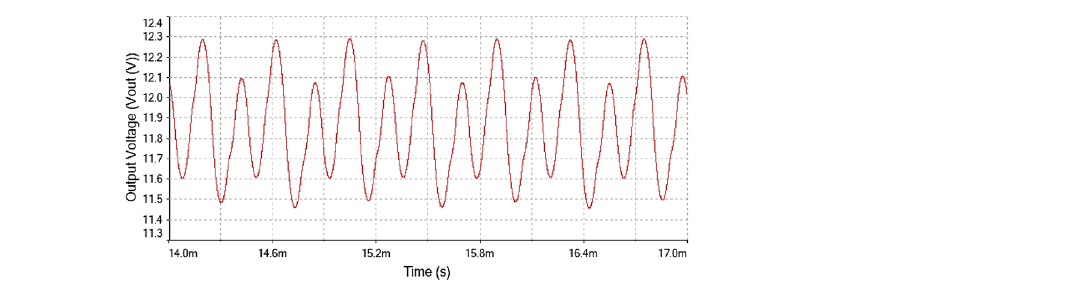
Figure 25. Output voltage waveform for forward converter at at R L = 9 (cid:31)